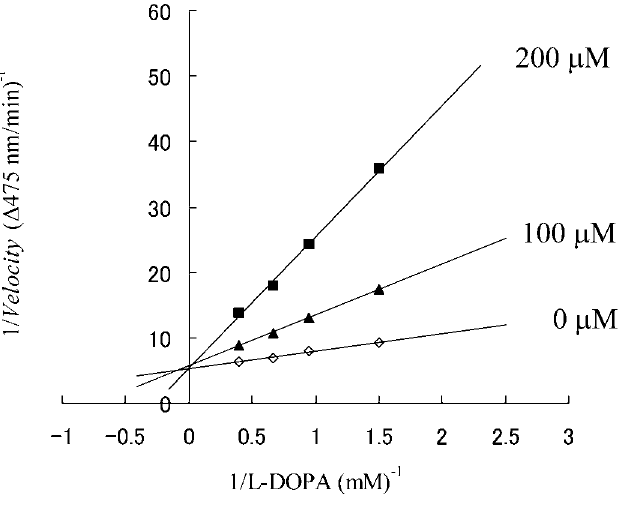
Figure 3. Lineweaver-Burk plots for the inhibition of tyrosinase by 6-hydroxykaempferol ( 14 ) with respect to L -DOPA as